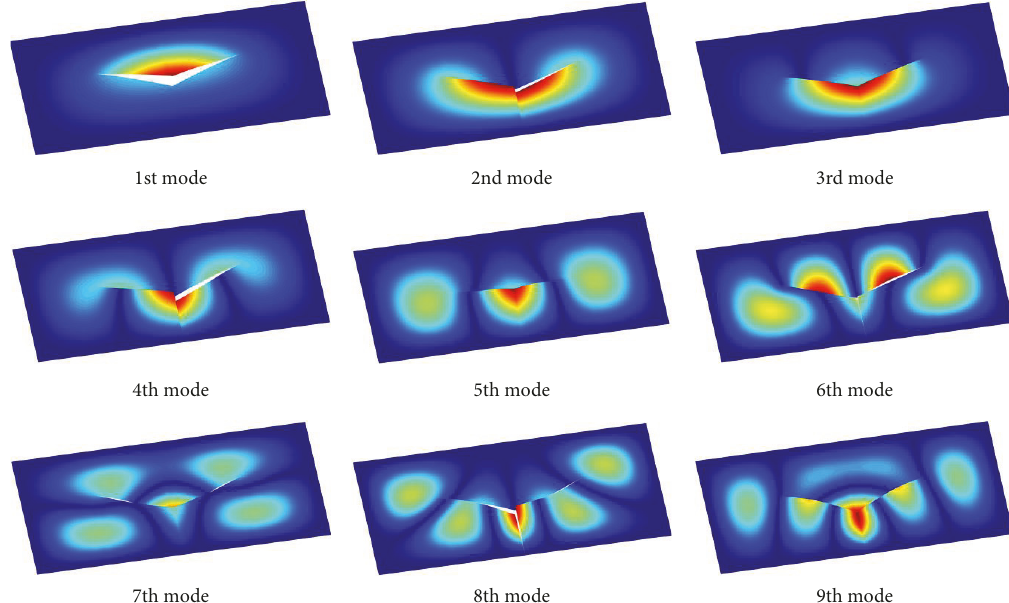
Figure 12: The first nine mode shapes of the CCCC plate with irregular T-shaped crack.